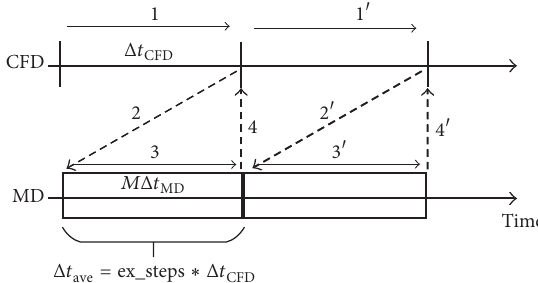
Figure 6: Time coupling and advancing mechanism in the current HAC method. In one coupling cycle, it includes four steps, that is, the CFD advancing, the 𝐶 → 𝐴 operation, the MD advancing, and the 𝐴 → 𝐶